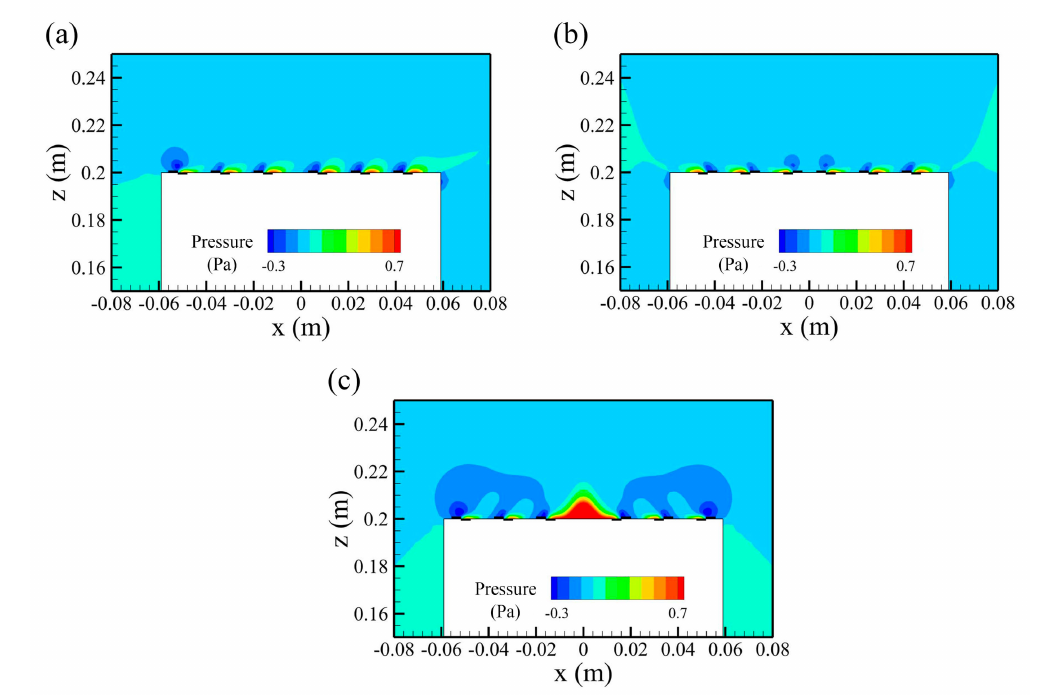
Figure 9. Pressure contours: ( a ) case A; ( b ) case B; ( c ) case